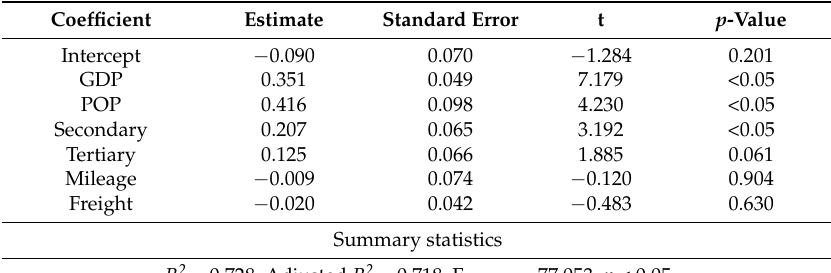
Table 3. Fixed effects estimator of the panel regression (dependent variable: Developed).